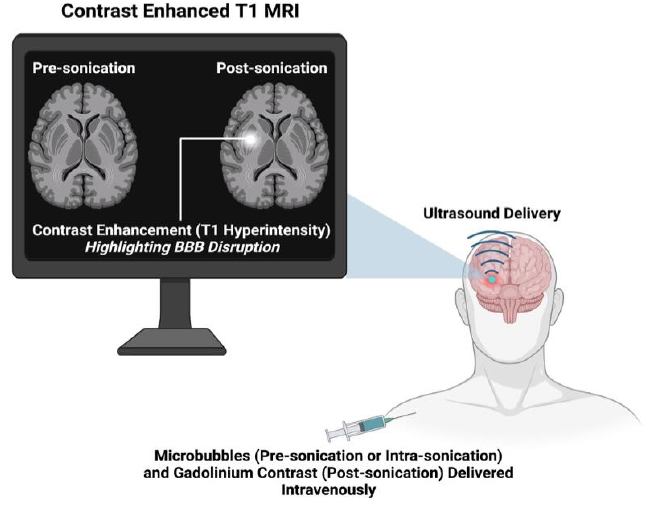
Figure 4 . Representative cartoon highlighting the assessment and confirmation of ultrasound-me- diated BBB disruption using CE-T1 MRI. ( Created with Biorender.com. ) mediated BBB disruption using CE-T1 MRI. ( Created with Biorender.com (accessed on 12 March